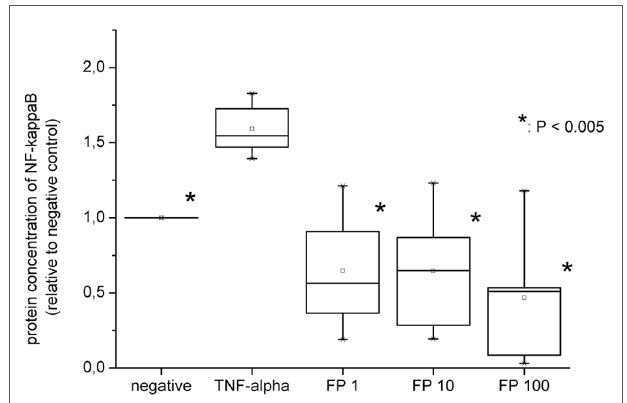
Figure 4. Protein levels of nuclear NF- κβ measured by ELISA. All the relative values were compared to negative control (considered as